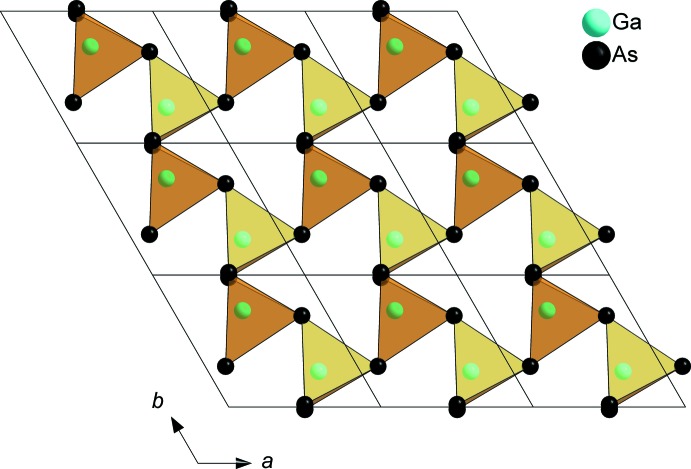
Edge- and corner-sharing GaAs4 tetra­hedra forming a layer with triangular voids viewed along [001].